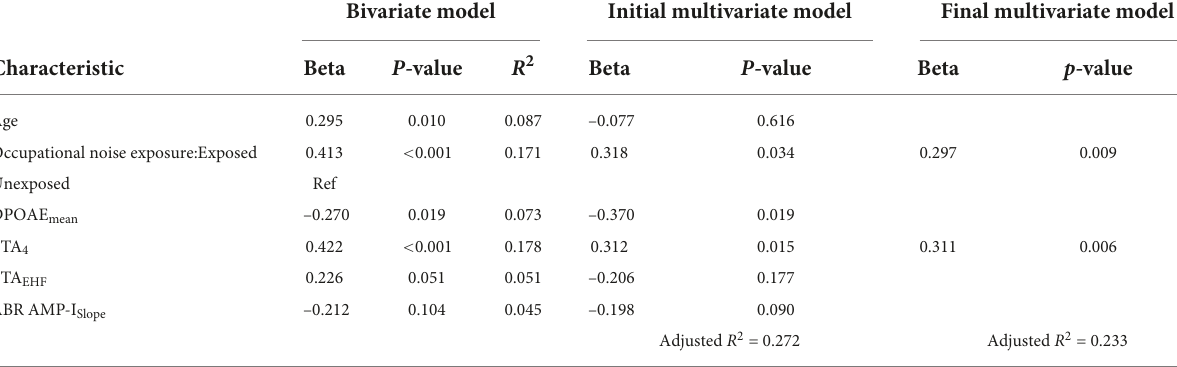
TABLE 3 Bivariate and multivariate linear regression analyses for BKB